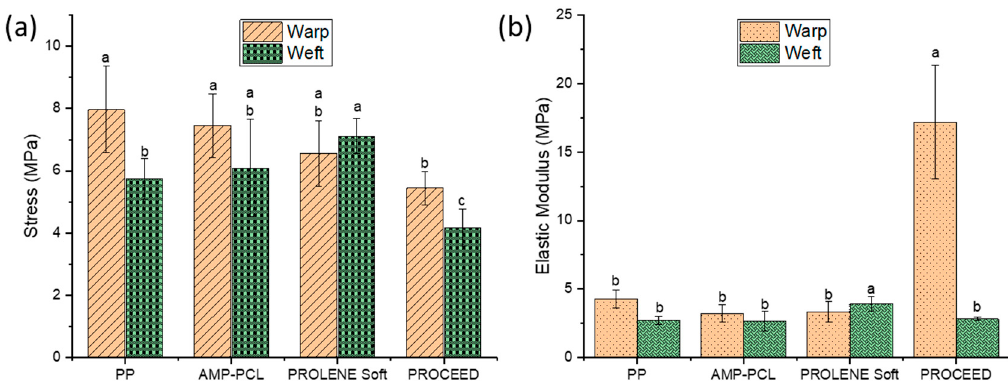
Figure 3. Tensile strength test of samples. ( a ) The max tensile stress; ( b ) the elastic modulus in warp and weft directions. Different letters in panels (a, b, c) indicate statistically significant differences (P < 0.05).